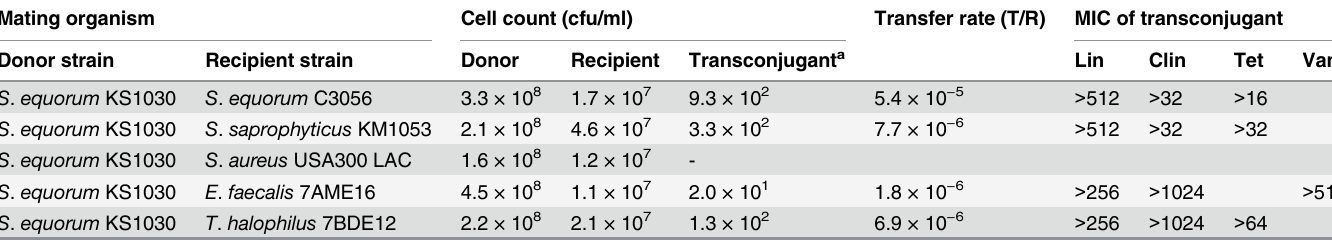
Cell counts were repeated three times independently and the mean values of the replicates are presented. R, recipient; T, transconjugant.